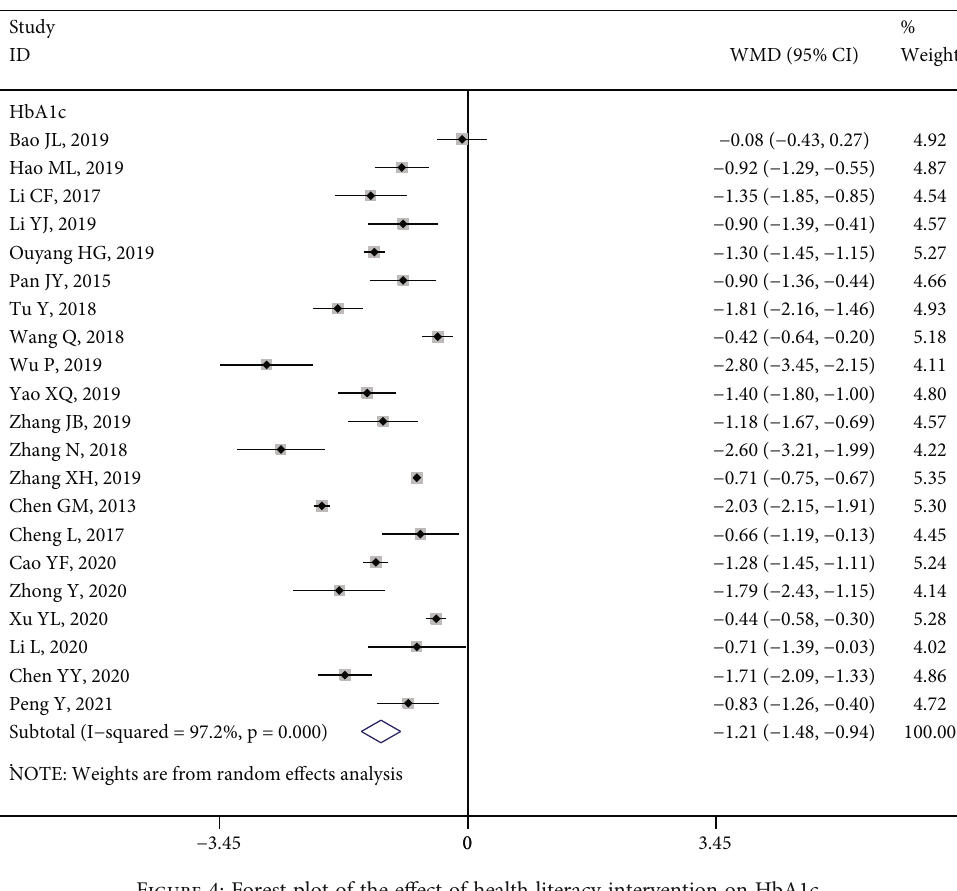
Figure 4: Forest plot of the e ff ect of health literacy intervention on HbA1c.